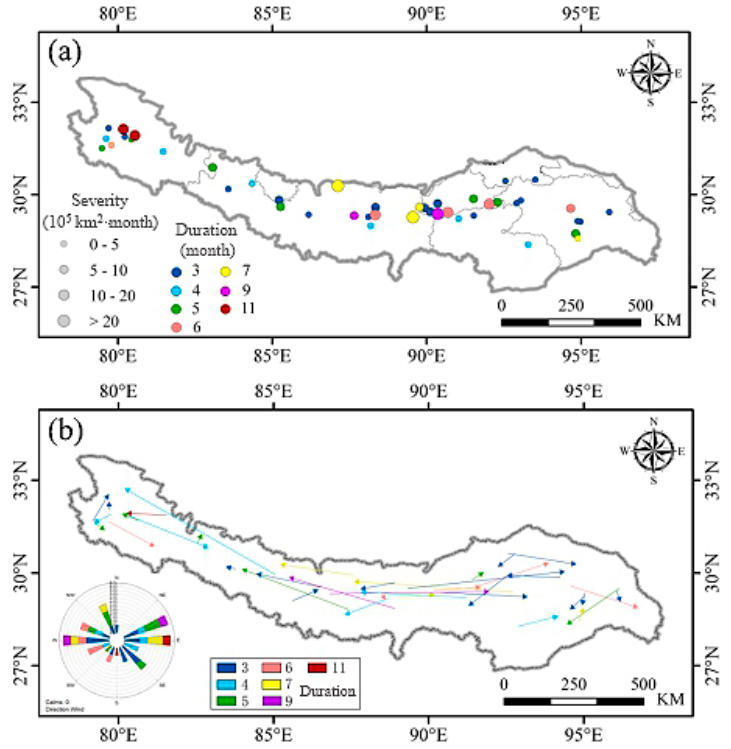
Figure 5. Spatial distribution of drought events from 1982 to 2015, ( a ) the event centroids based on SPI-3, ( b ) spatial orientation of drought events. The head of the arrow is represented by the severity-weighted centroid in the first month of the event and the tail of the arrow is represented by the severity-weighted centroid in the last month of the